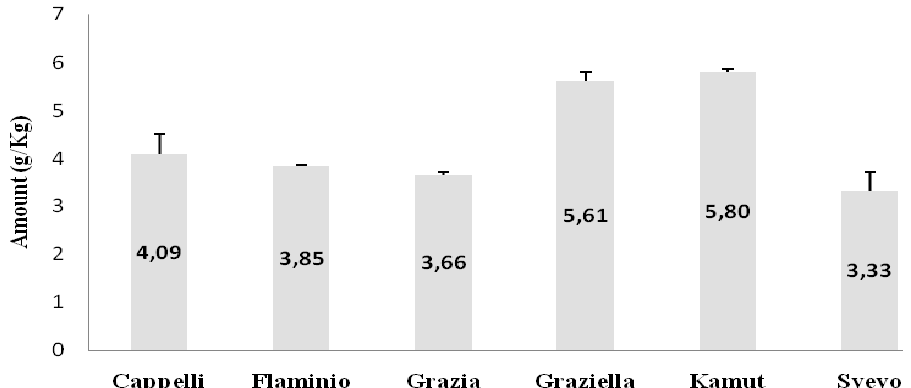
Figure 2. A-gliadin peptide p31-49 (LGQQQPFPPQQPYPQPQPF) quantitative determination by PN3 mAb. All values are reported as mean ± SD from three independent